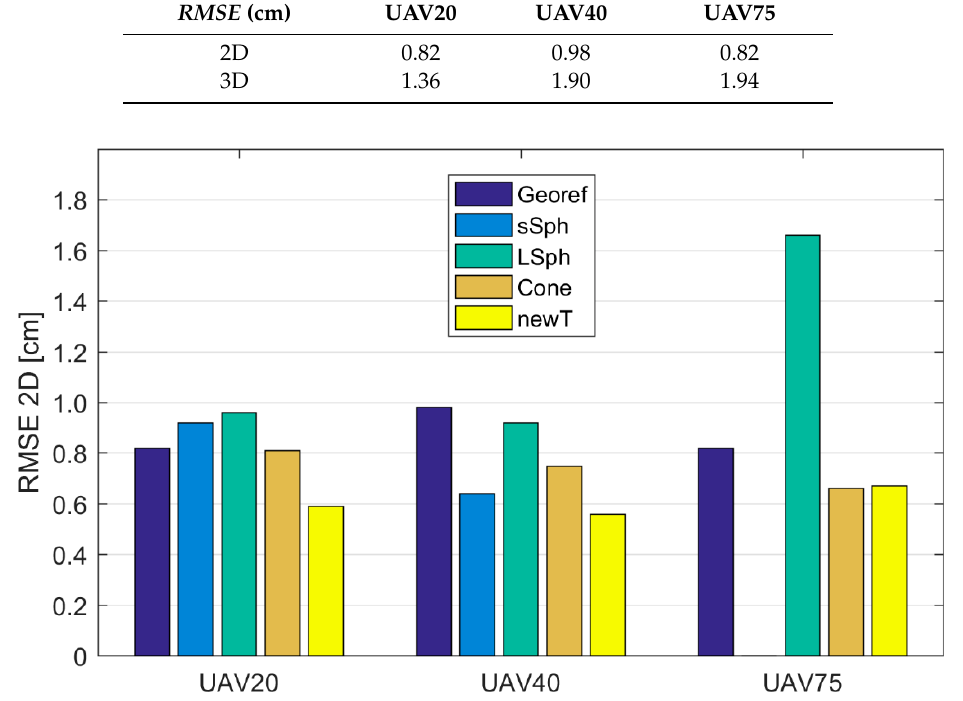
Figure 13. The RMSE 2 D on check points, following the registration of UAV and TLS point clouds, taking into account the used tie point, given in cm. “Georef” represents the RMSE prior to the registration of the TLS and UAV point clouds.